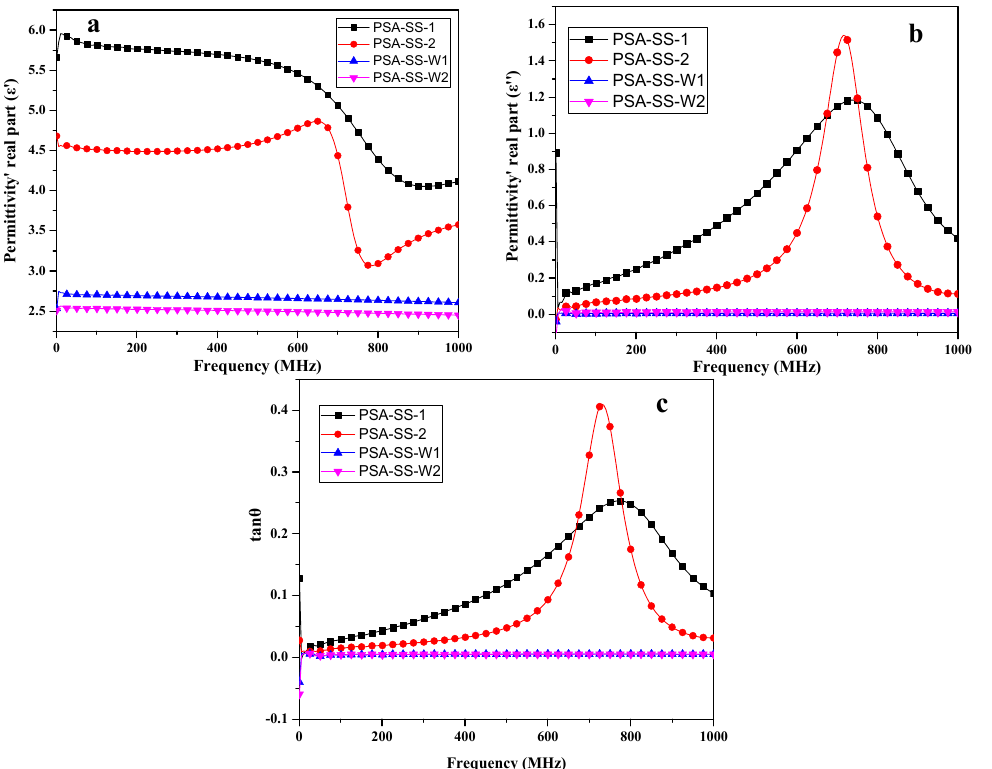
Figure 6. The influence of different wire content fabrics on the ( a ) permittivity’s real part ( ε ’); ( b ) permittivity’s imaginary part ( ε ’’) and ( c ) loss tangent (tan θ ) . ( b ) permittivity’s imaginary part ( ε ”) and ( c ) loss tangent (tan θ